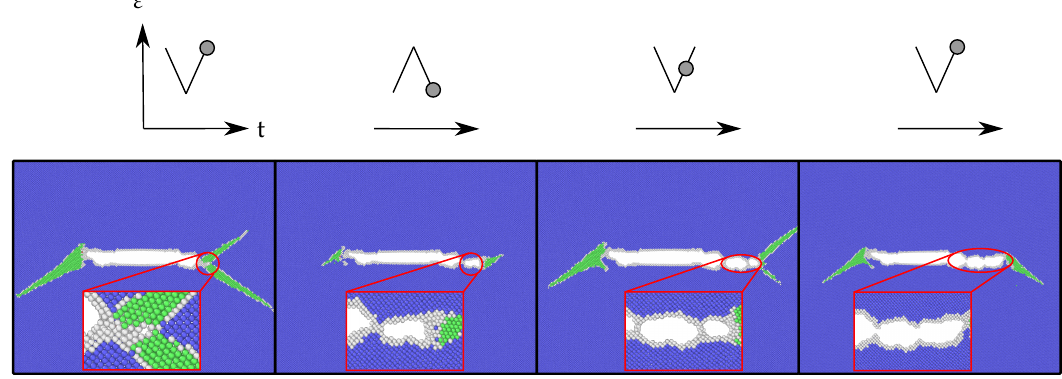
Figure 10. Formation and coalescence of